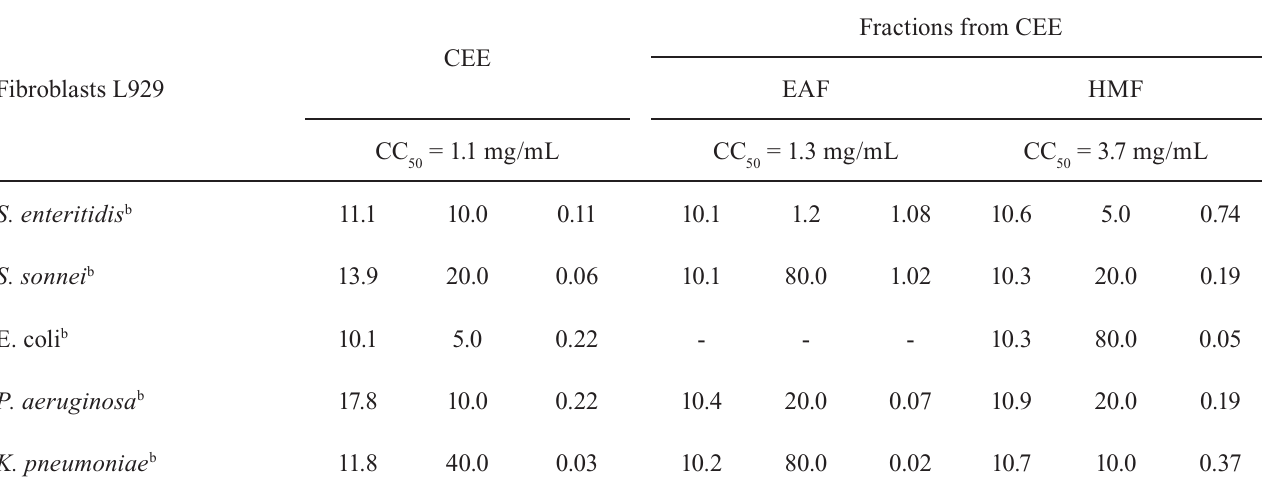
TABLE I - C ytotoxicity and antibacterial activity of ethanol extract (CEE) from leaves of P. spruceanum and its fractions